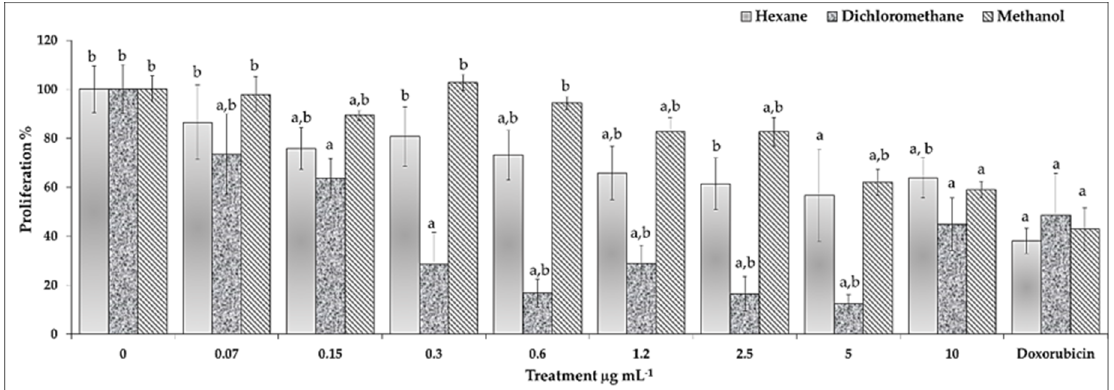
Figure 3. Antiproliferative activity of the extracts S. edule cv. Madre Negra depending on the solvent used: hexane, dichloromethane, or methanol. a: significant difference versus control (0) ( p < 0.05), b: significant difference versus positive control for the inhibition of proliferation (5 ng/mL of doxorubicin) ( p < 0.05) (ANOVA with a Tukey test). The bars indicate ± standard deviation. Table 1. Cell inhibition values (IC 50 ) of the S. edule cv. Madre Negra depending on the type of solvent used.